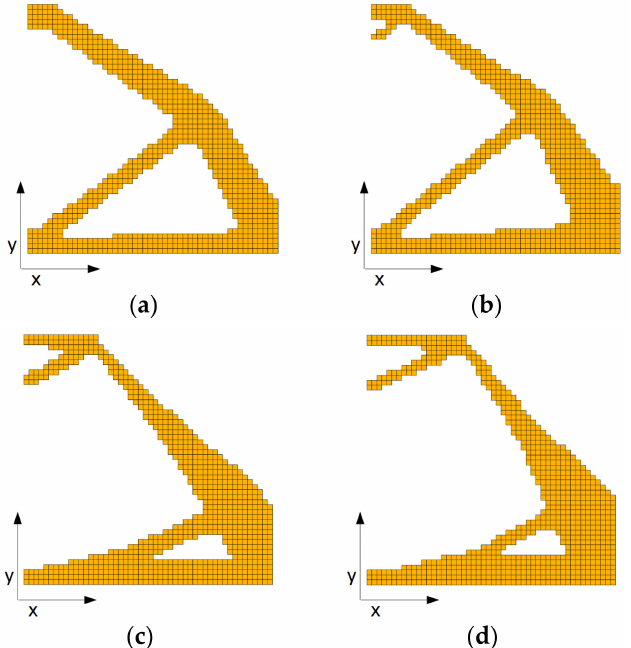
Figure 9. Final topologies obtained for square structure for the FGM-SIMP material interpolation scheme and x and y -directions of material gradation: ( a ) α = − 0.02, β = − 0.02, minimal compliance: 8.472 Nm; ( b ) α = − 0.04, β = − 0.04, minimal compliance: 32.982 Nm; ( c ) α = − 0.06, β = − 0.06, minimal compliance: 155.825 Nm; ( d ) α = − 0.08, β = − 0.08, minimal compliance: 824.605